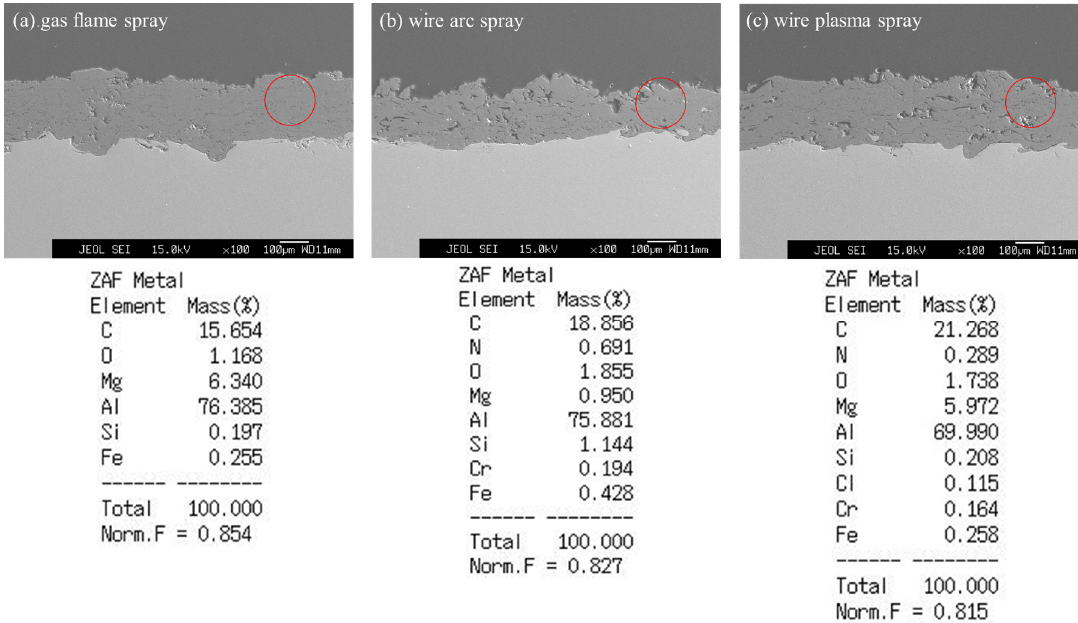
Figure 3. Cross-sectional views obtained using SEM (above) and the results of the semi-quantitative analyses (following the instruction commonly referred to as the “ZAF” corrections) using an electron probe micro analyzer (EPMA) for coating layers deposited using the three thermal spray guns (below, which are direct-printouts pasted here from the EPMA instrument). ( a ) Gas flame spray; ( b ) Arc spray; ( c ) Plasma spray.